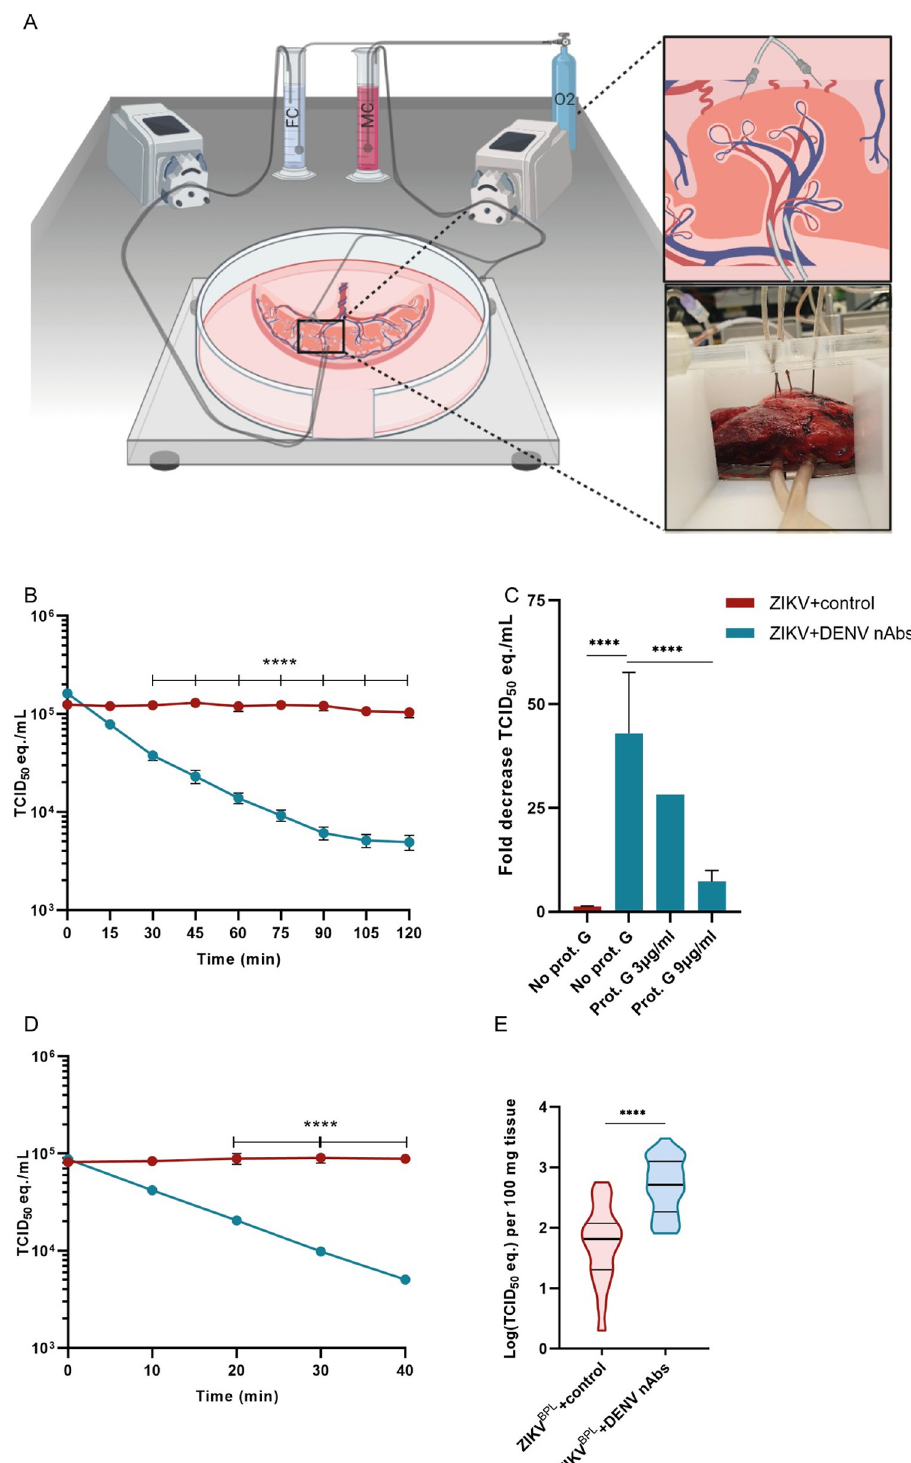
Fig 1. Efficient uptake of ZIKV immune complexes by ex-vivo perfused placentas. 1 � 10 5 TCID 50 equivalent/mL inactivated ZIKV (ZIKV BPL ) was incubated with either flavivirus na ï ve serum or serum containing DENV-2 nAbs and added to the maternal circulation (MC) of the placental perfusion model and perfused for 40 or 120 minutes. A: Schematic overview of the ex vivo dual placental perfusion model. FC; fetal circulation. Created with Biorender.com.